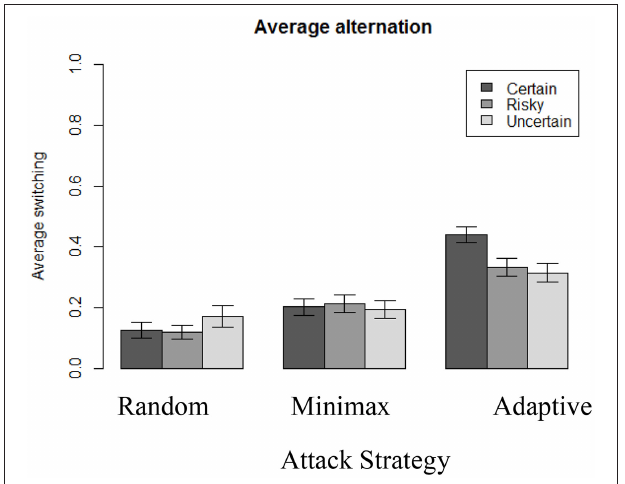
FIGURE 7 | Average switching behavior in each